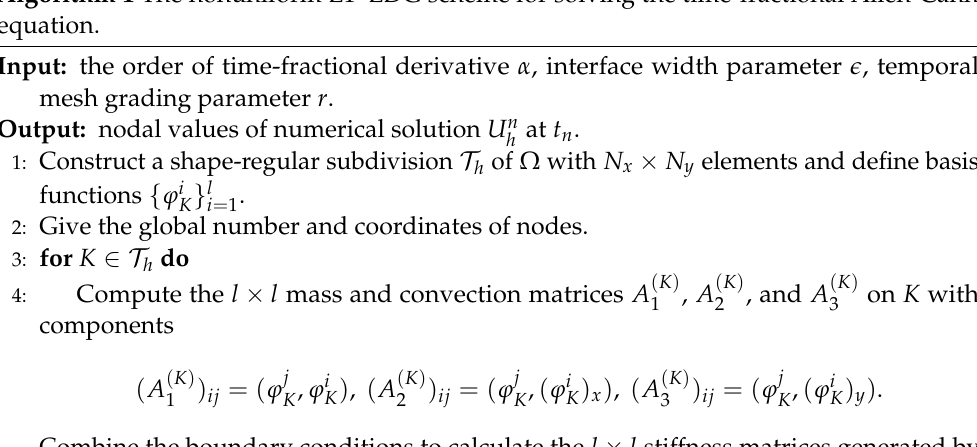
Algorithm 1 The nonuniform L1–LDG scheme for solving the time-fractional Allen-Cahn